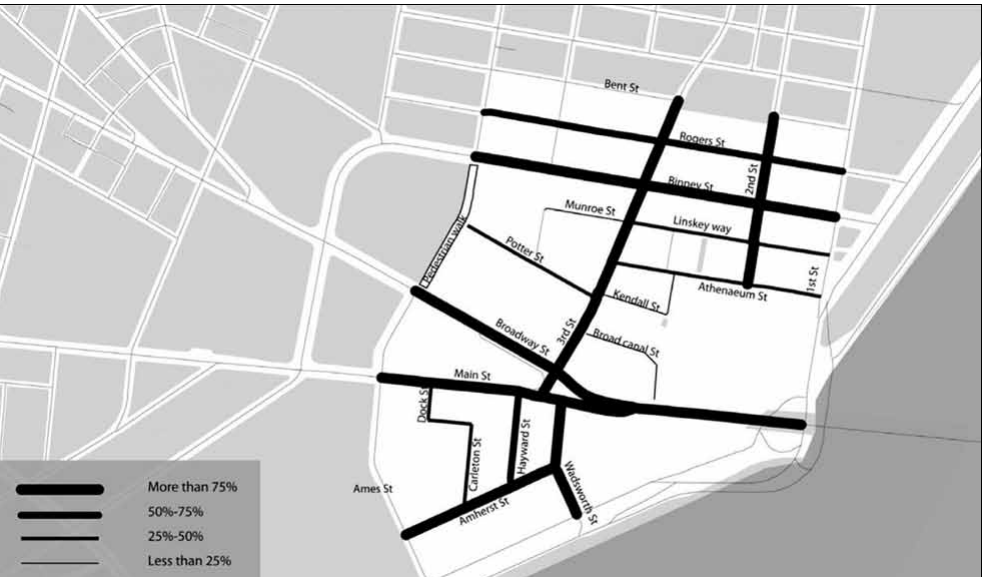
fig. 5. Kendall Sq. compiled map of accurate perceived streets based on